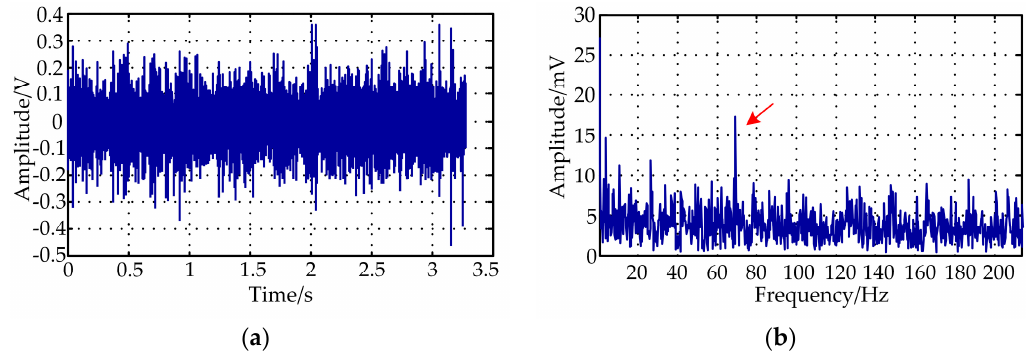
Figure 7. The outer ring fault bearing